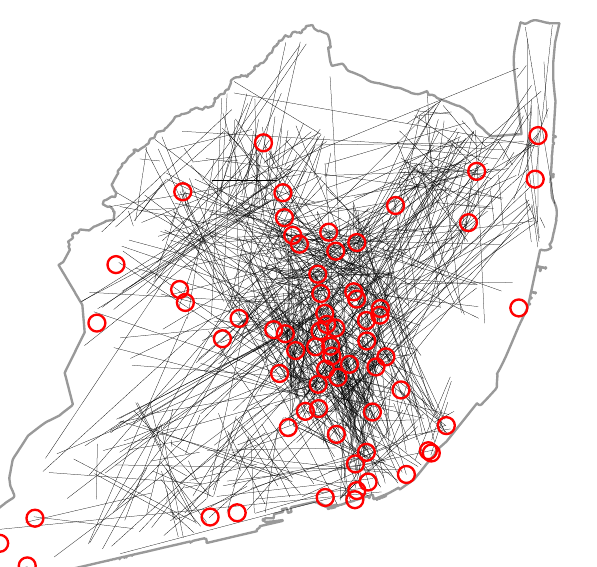
Figure 4. Trips represented with jittered desire lines, with disagregation of 500 trips.